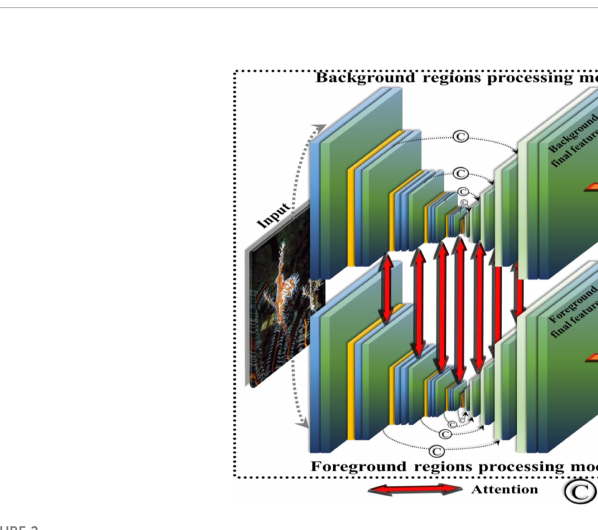
FIGURE 2 Feature fusion-based segmentation of